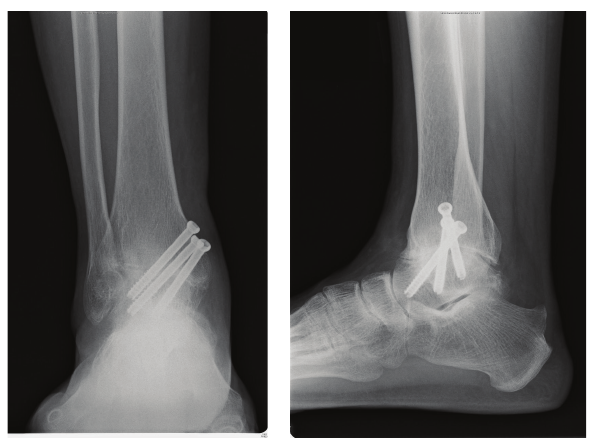
Figure 4: Postoperative radiographs. The bone union is adequate, and no screw loosening is